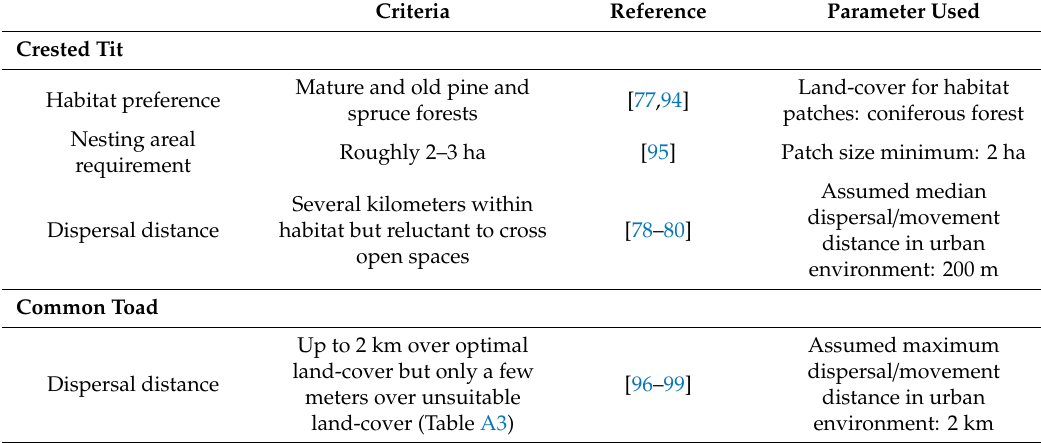
Table A1. Crested tit and common toad species criteria according to Mörtberg et al. [66,67] and corresponding parameters used in the present study.